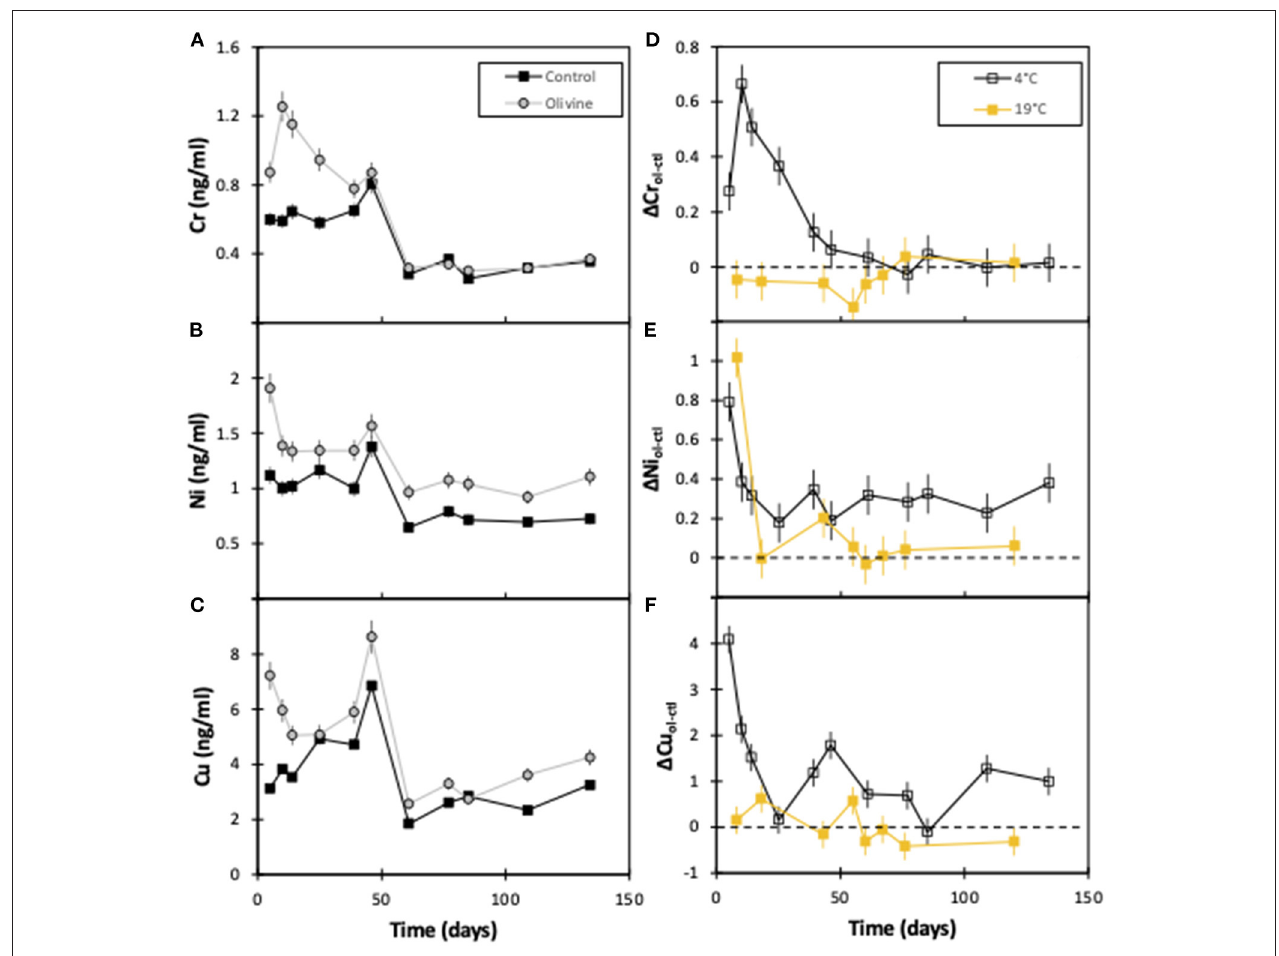
FIGURE 3 | Effluent trace element concentrations as a function of experimental time for both columns: (A) chromium, (B) nickel, (C) copper. (D–F) show the difference in heavy metal concentration between the olivine and control core for this (4 ◦ C) and the 19 ◦ C experiments (Renforth et al., 2015). The error bars represent the 2sd analytical uncertainties. For the 1 panels (D–F) , the analytical uncertainty has been compounded through the